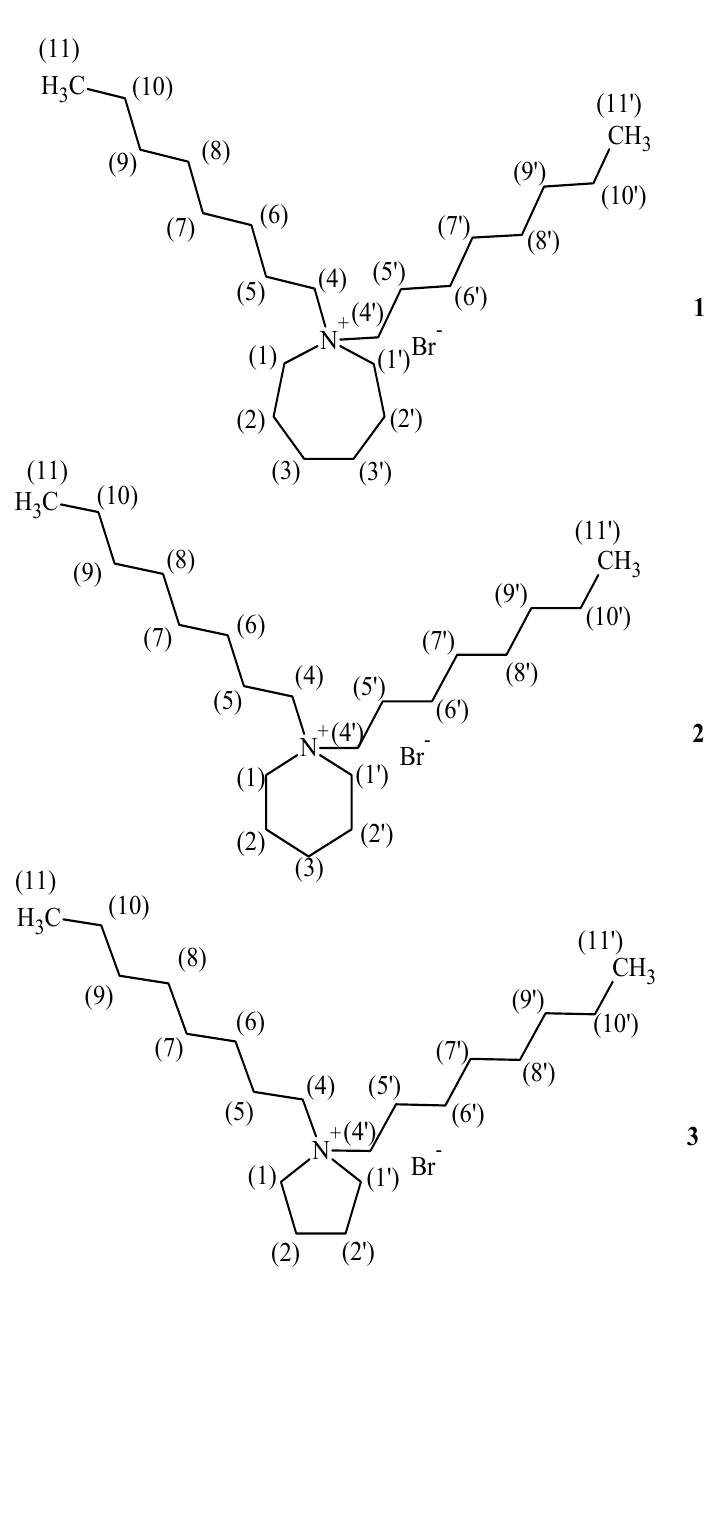
Figure 1. The structure and numbering for N,N -dioctylazepaniumbromide ( 1 ), N,N